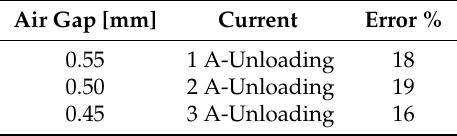
Figure 7. Magnetic flux density norm (surface plot) and magnetic vector potential (contour plot) over the cross-section of the 3D model based on the FeCrCo 48/5 at 0.55 mm air gap and 6 A supplied current. Table 3. Maximum relative error in the predicted force for the electromagnet based on FeCrCo 48/5.